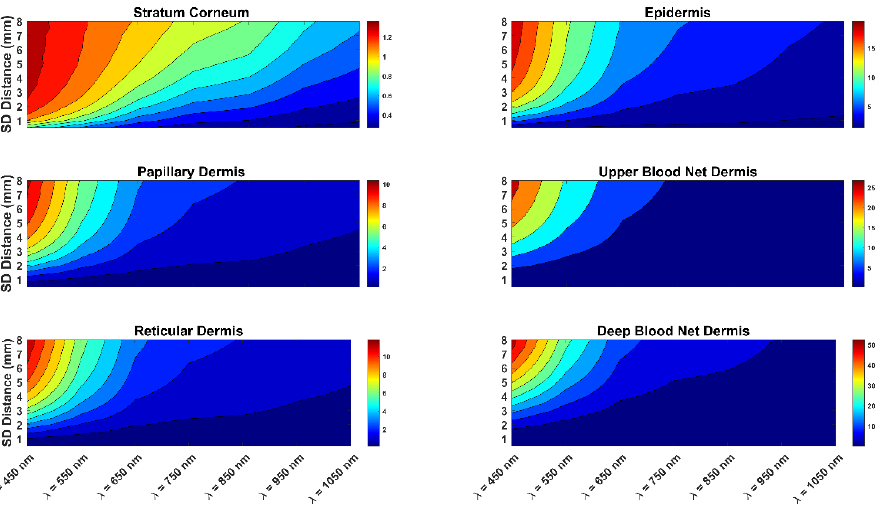
Figure 2. Optical pathlength of light photons for different skin layers at 2% melanin concentration. The figure shows the effects of different light source wavelengths and source-to-detector separations on the optical pathlength of photons.